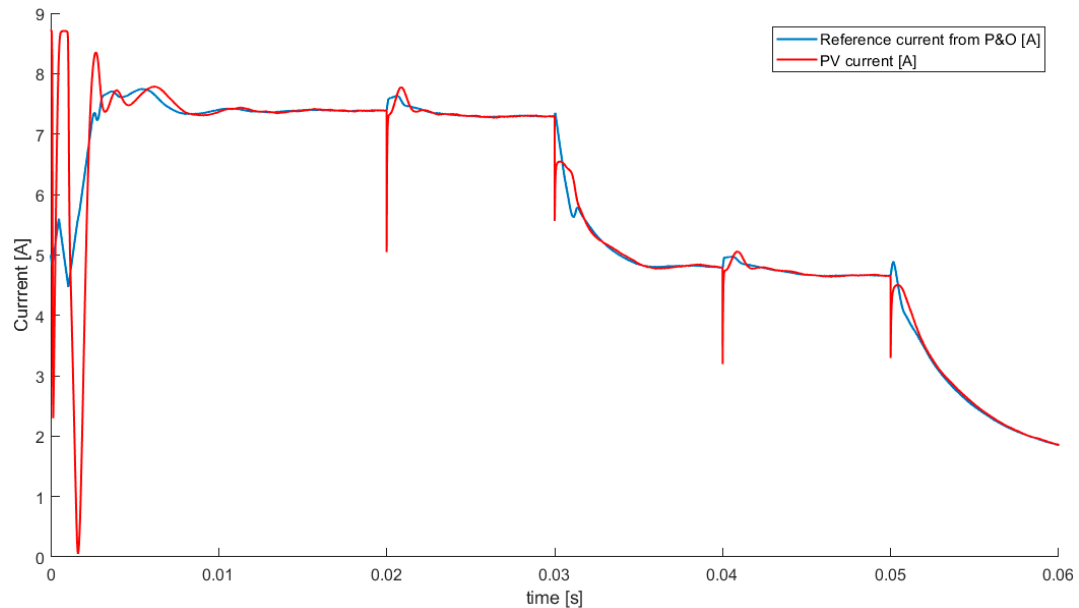
Figure 19. Evolution of PV current over time.